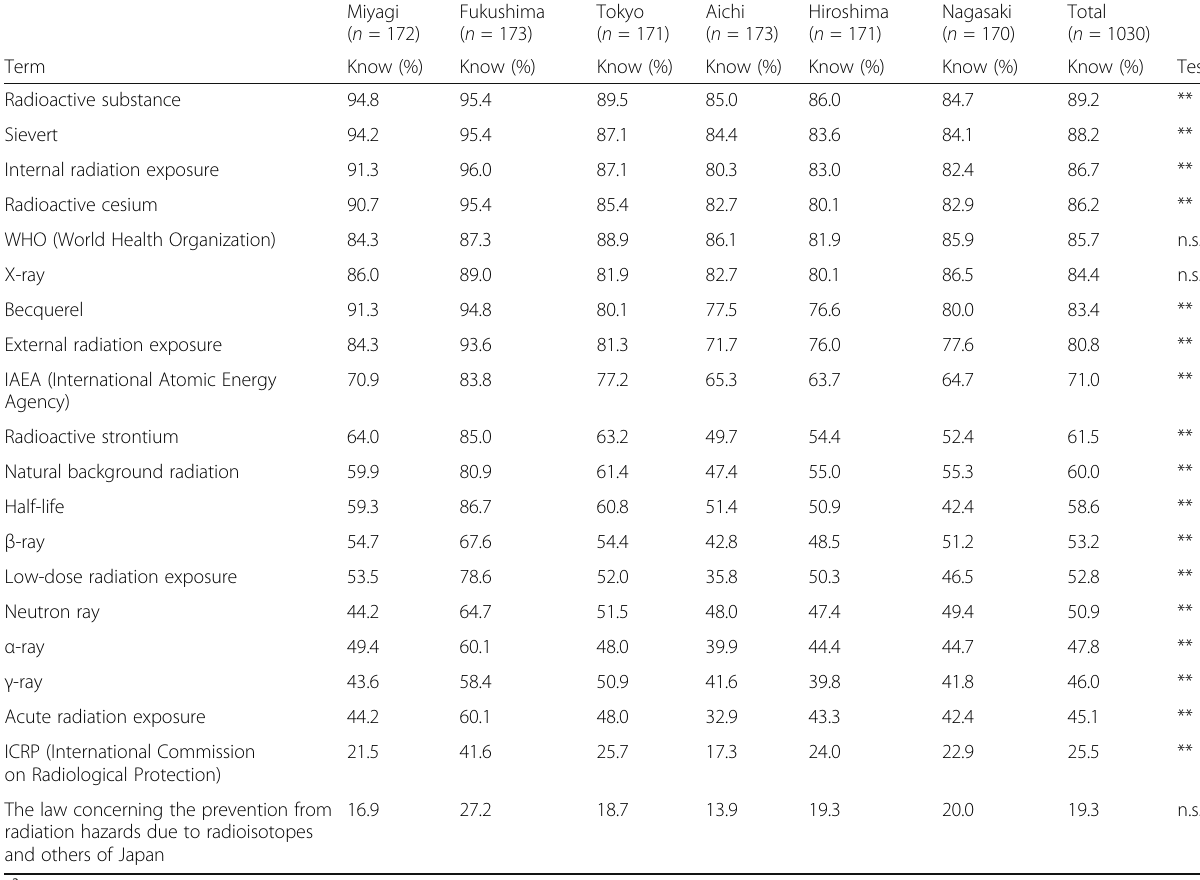
Table 5 Difference in the percentage of “ Know ” on the recognition level of the 20 technical terms regarding radiation among residents of the six